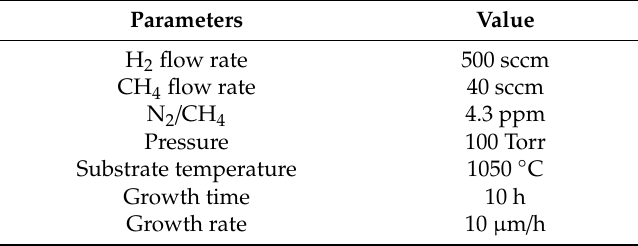
Table 1. Details of experimental conditions of diamond growth with N